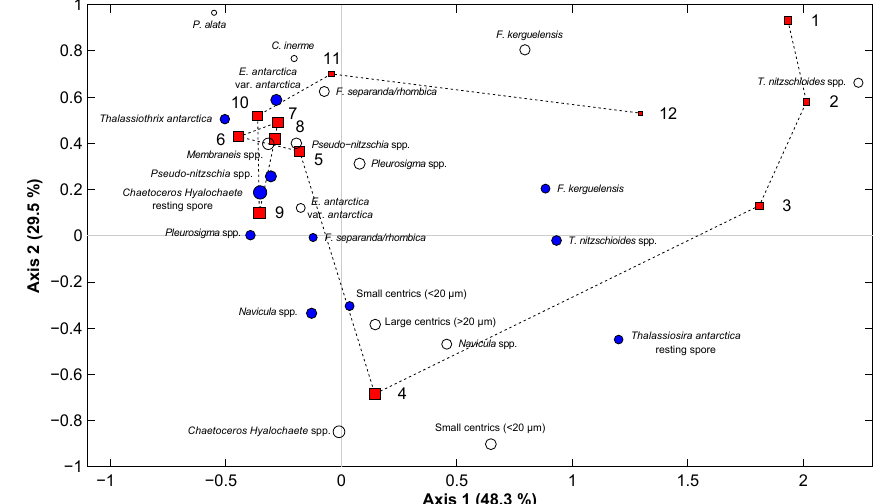
Figure 3. Factorial map constituted by the first two axes of the correspondence analysis performed on the full and empty diatom cell fluxes. Red squares are cup projections with cup numbers specified, blue circles are full cell projections and white circles are empty cell projections. The size of the markers is proportional to their representation quality in this factorial map.